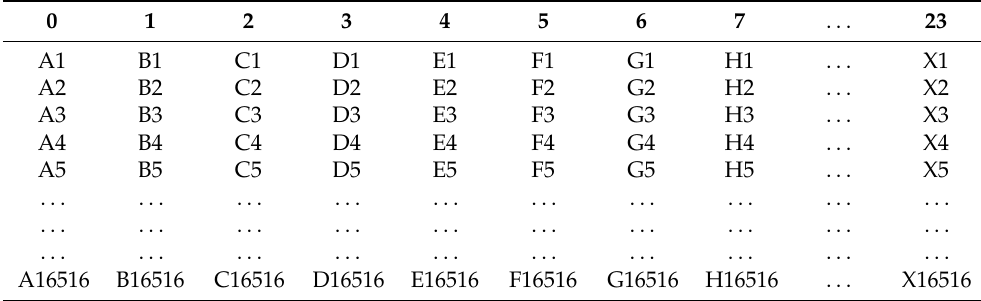
Table 2. Data in each experimental